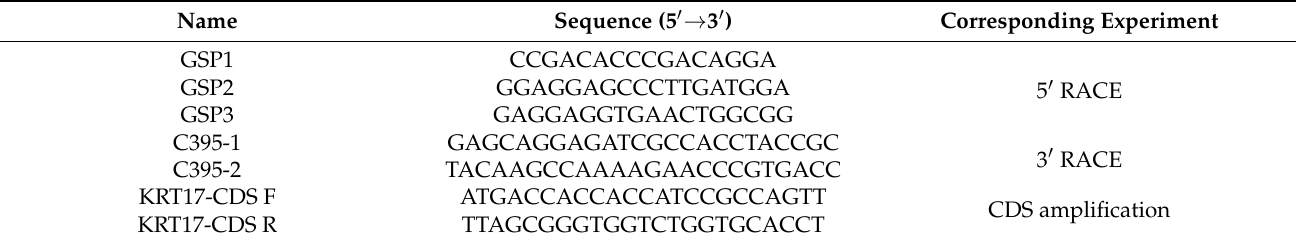
Table 8. RACE primers for KRT17